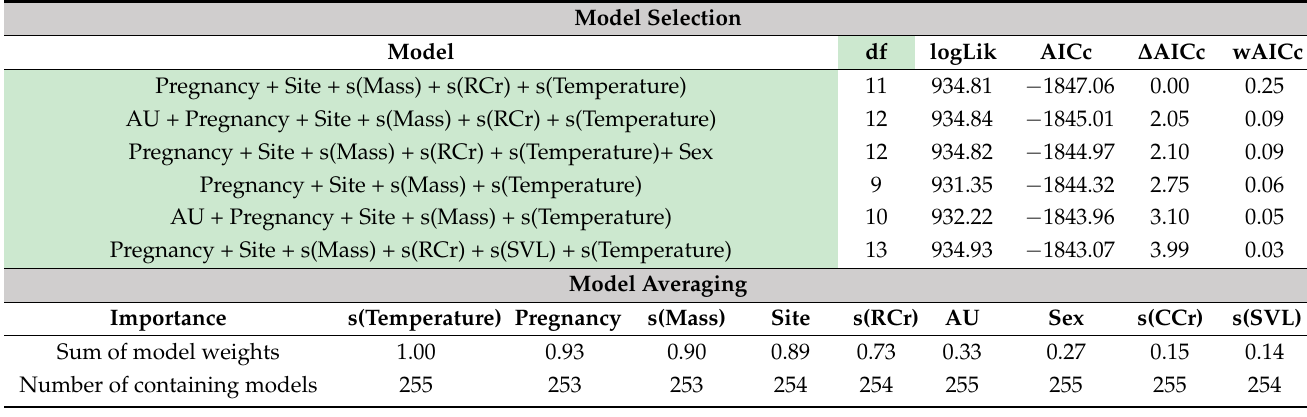
Table 3. Model selection and averaging of generalized additive mixed-effects models (GAMMs) relating predictors to locomotor performance (sprint speed) of the lizard Micrablepharus atticolus . Models depicted are those with ∆ AIC c < 4. AU: caudal autotomy (yes/no), RT: length of regenerated portion of tail, AIC c : Akaike information criterion corrected for small samples, ∆ AIC c : difference between given and best model, wAIC c : Akaike